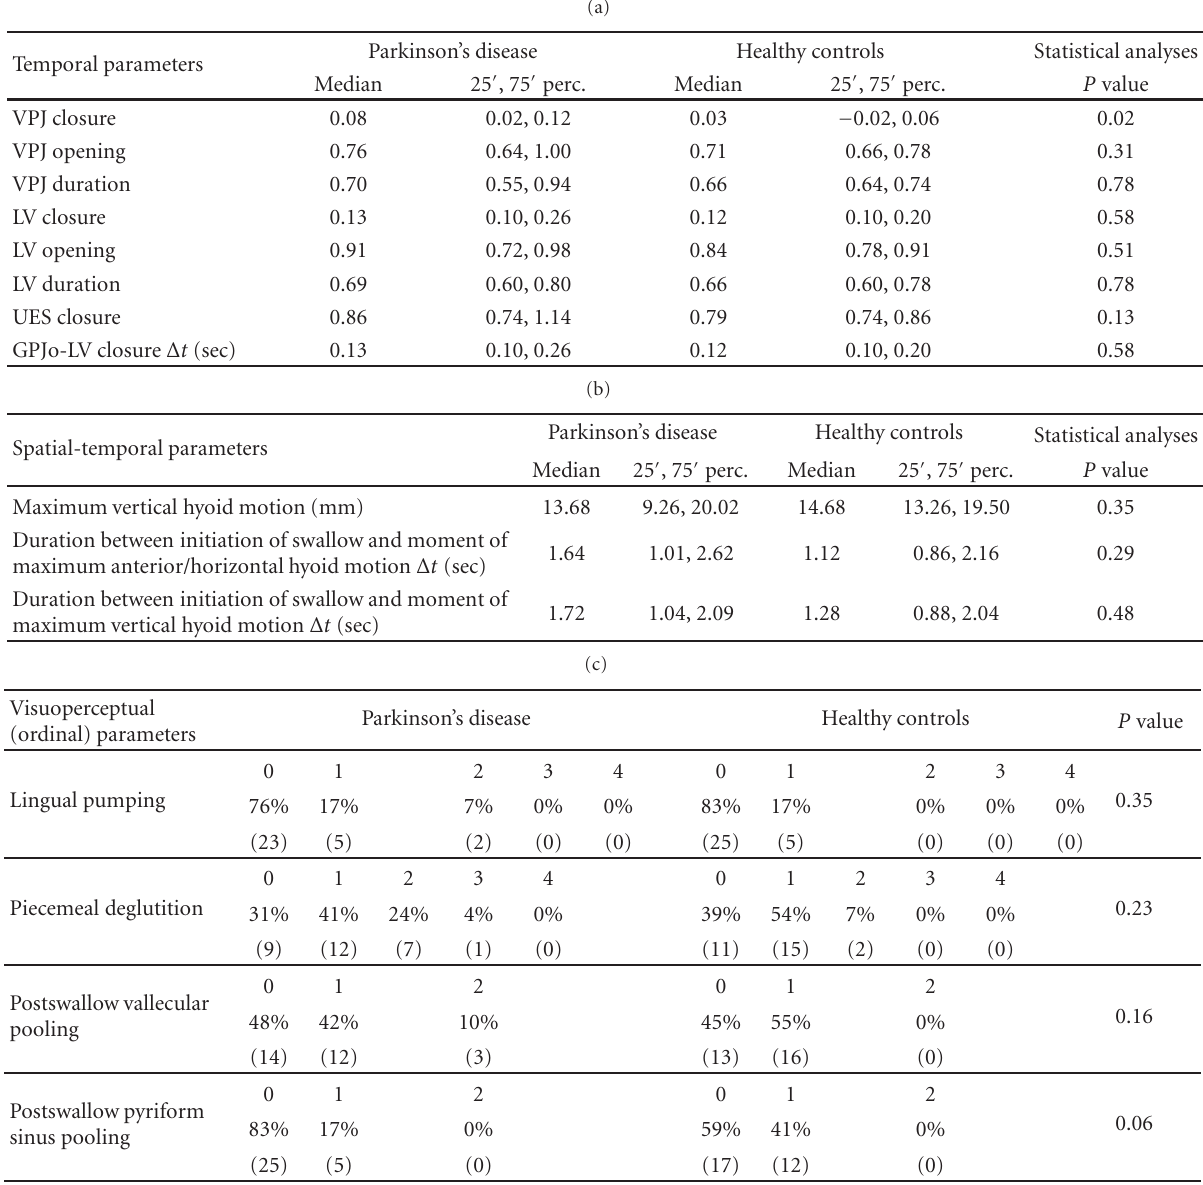
Table 4: (a) Descriptive statistics of temporal data (quantitative assessment) and level of significance ( P ) for the comparison of di ff erences between Parkinson patients and the healthy control subjects (Mann-Whitney U test asymp. sig., 2-tailed). (b) Descriptive statistics of spatial- temporal data (hyoid motion) and level of significance ( P ) for the comparison of di ff erences between Parkinson patients and the healthy control subjects (Mann-Whitney U test asymp. sig., 2-tailed). (c) Crosstabulation of visuoperceptual data and level of significance ( P ) for the comparison of di ff erences between Parkinson patients and the healthy control subjects (Chi-Square test asymp. sig., 2-sided). The number of swallows per level of the three or five point scales is in